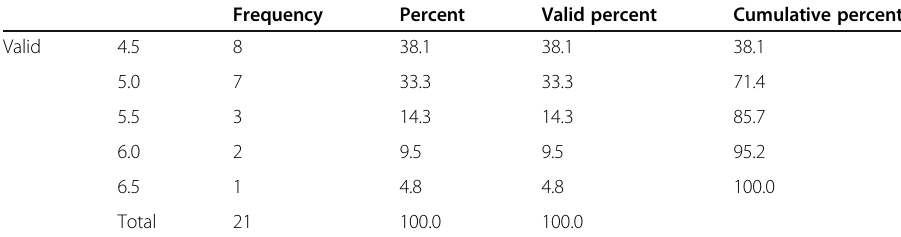
Table 1 Frequency of students ’ scores examined by trainer